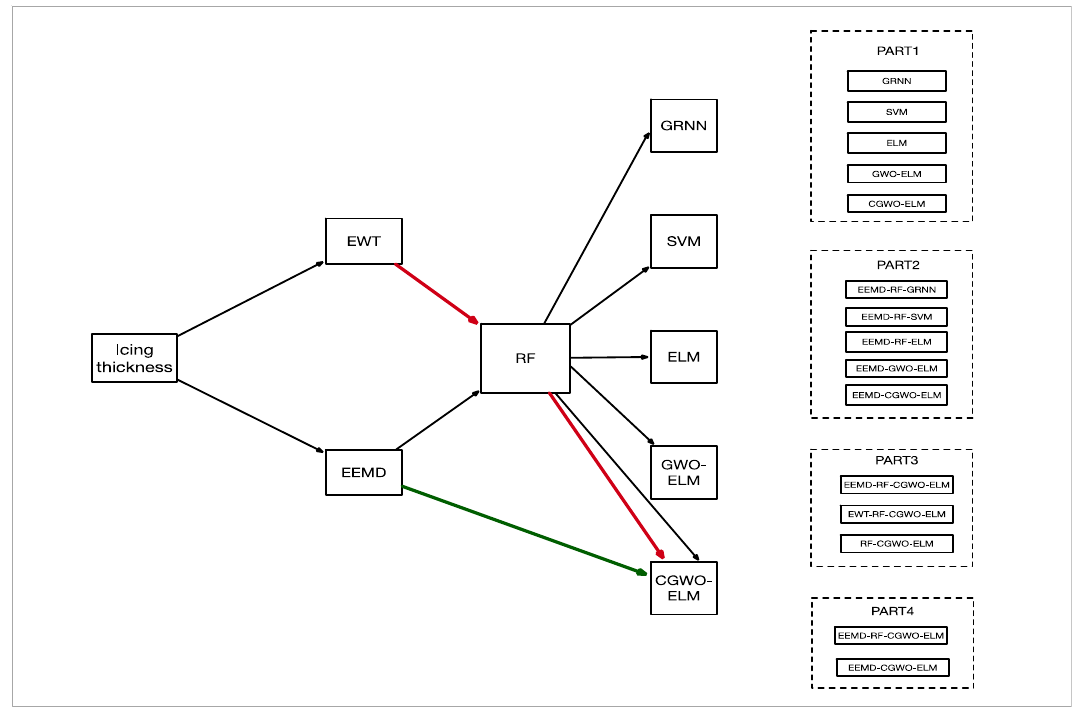
Figure 13. Framework of the forecasting model comparisons.